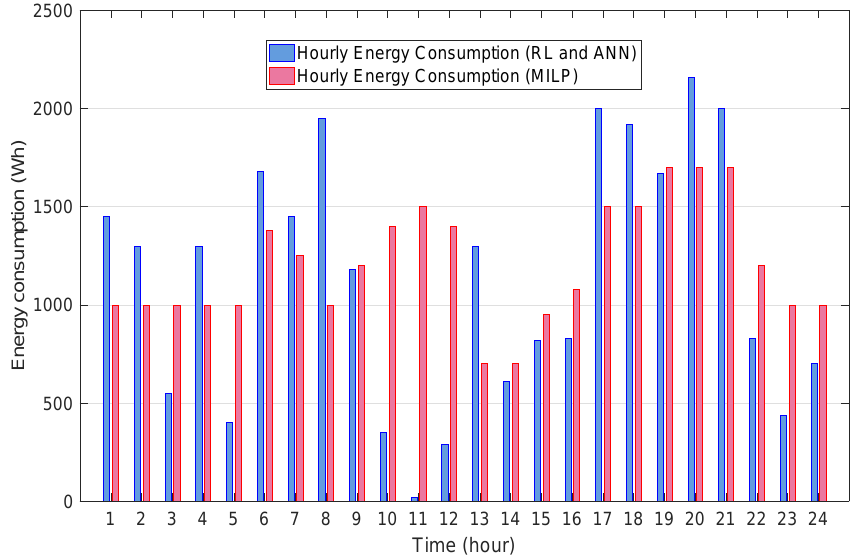
Figure 12. Comparison of hourly energy consumption schedule between MILP method and RL